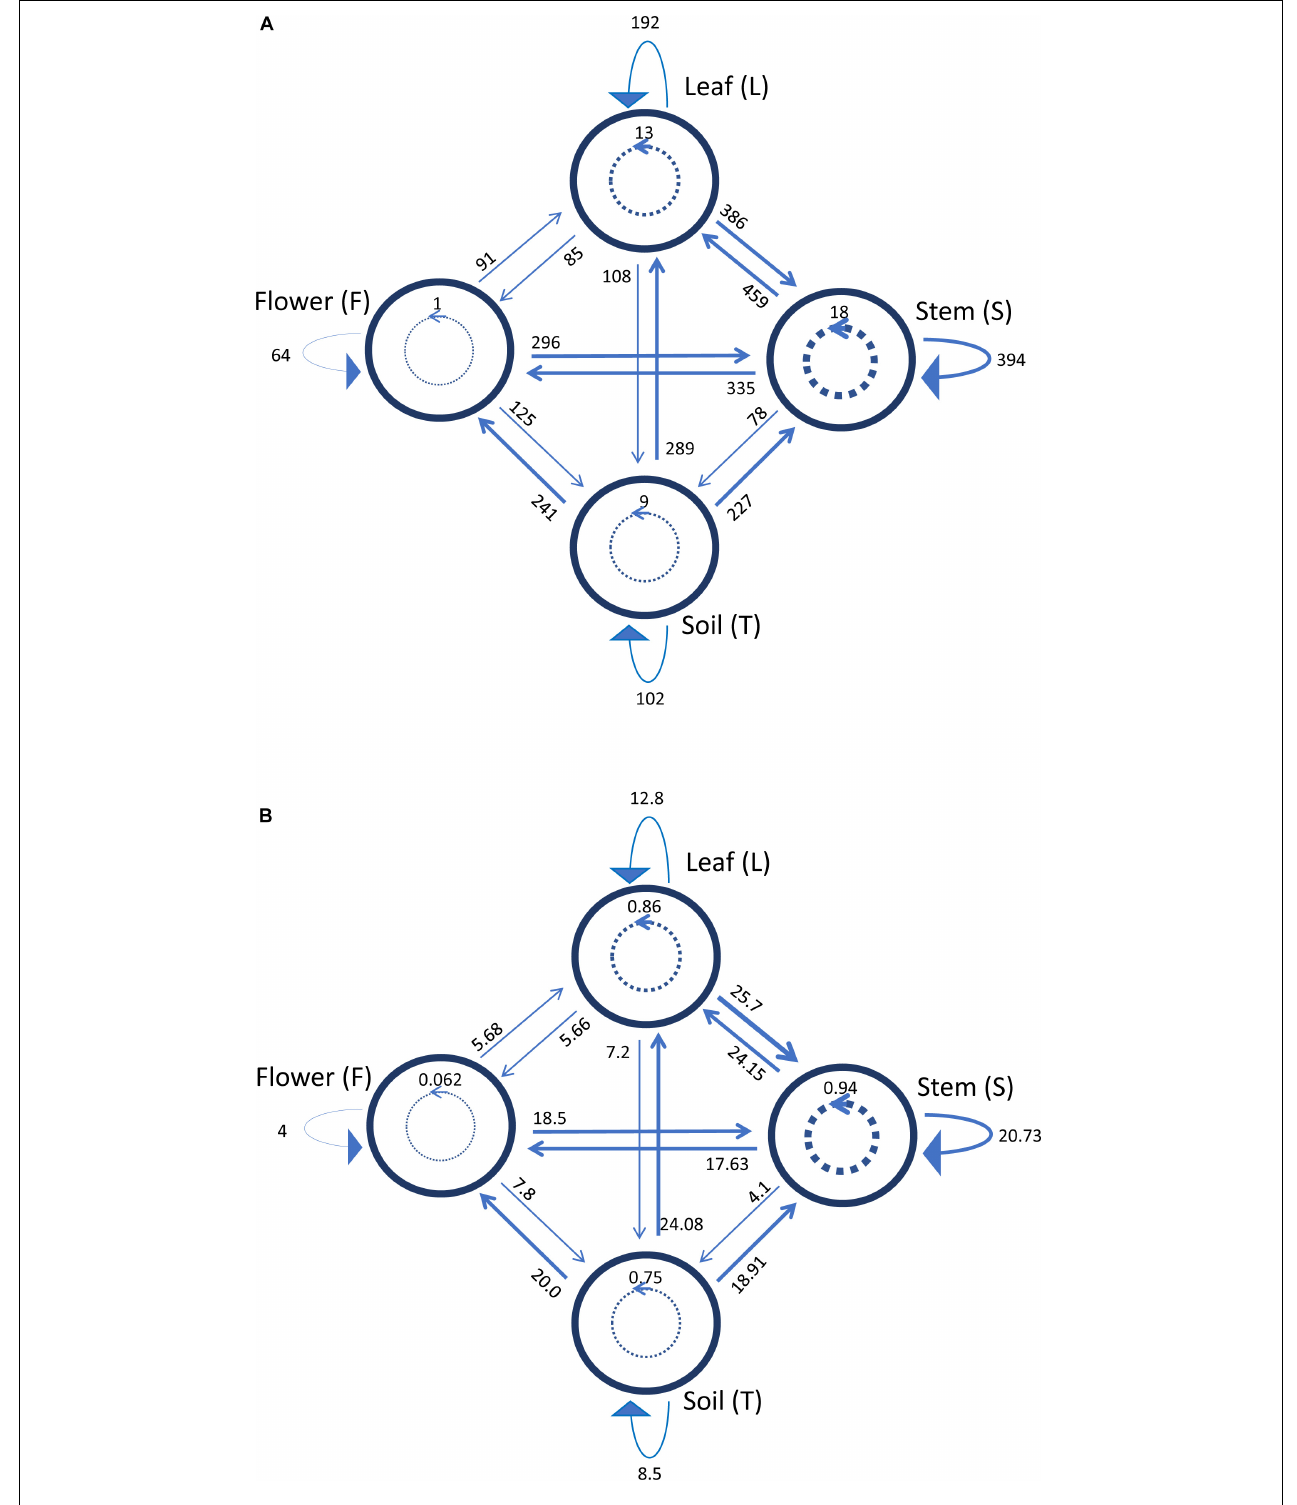
FIGURE 5 | Schematic representation of inhibiting activity of bacterial strains isolated from the medicinal plant O. vulgare bulk soil (T), stem (S), leaf (L) and flowers (F). Each node represents a plant compartment whereas numbers represent the sum of the inhibiting scores of the bacteria isolated from those compartments (A) and the inhibition potential of the tester strains calculated as the sum of inhibition scores divided by the tester number (B) . Directed links represent inhibition patterns. Dashed links indicate the occurrence and the extent of self-inhibition.